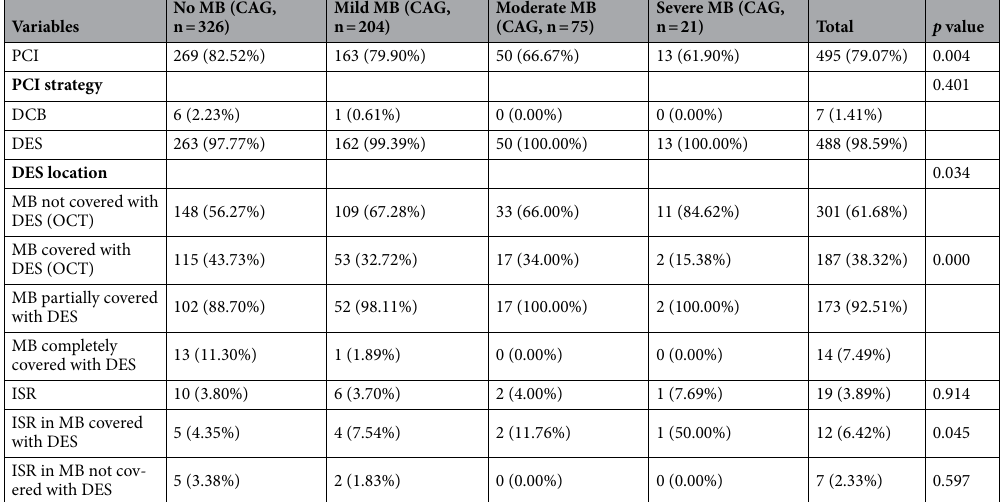
Table 5. PCI strategy and the 1-year follow-up ISR outcome guided by OCT among no MB, mild MB, moderate MB, and severe MB groups according to coronary angiography. Data were expressed as n (%). PCI percutaneous coronary artery, DCB drug-coated balloon, DES drug eluted stent, ISR in-stent